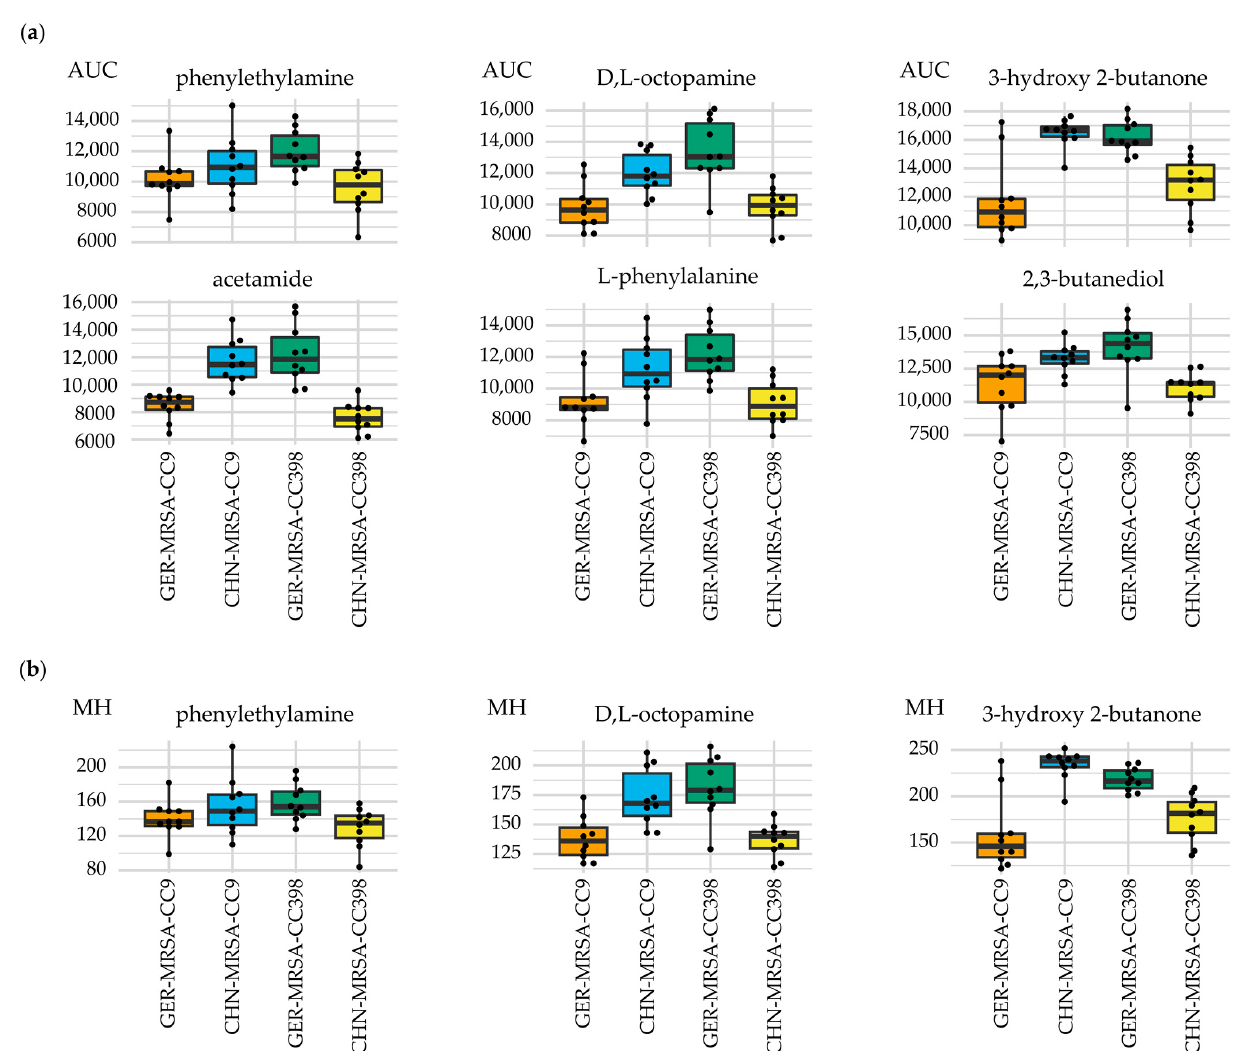
Figure 3. Relevant metabolic differences between the dominant and rare lineage within a CC regarding the usage of the substances given above the individual diagrams. The box plots display varying ( a ) area under the curve (AUC) values and ( b ) maximum height (MH) values of the four isolate groups.